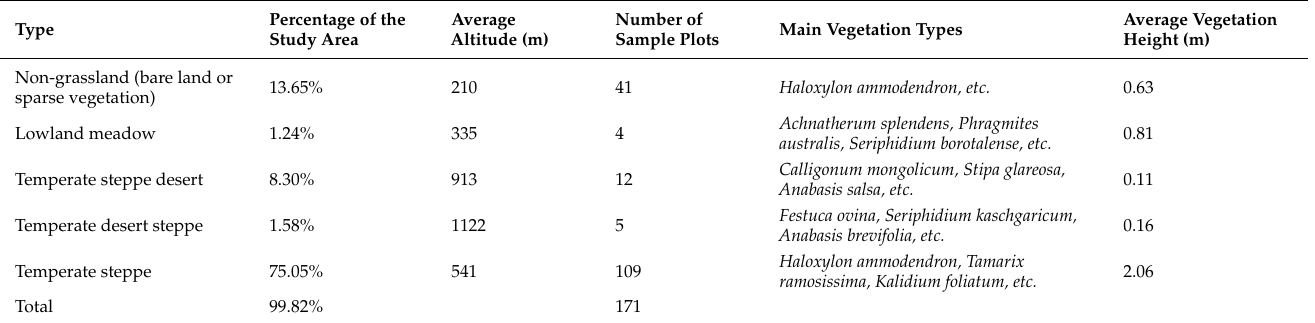
Table 1. Main grassland types, vegetation types, and number of sample plots in desert area of Junggar Basin,